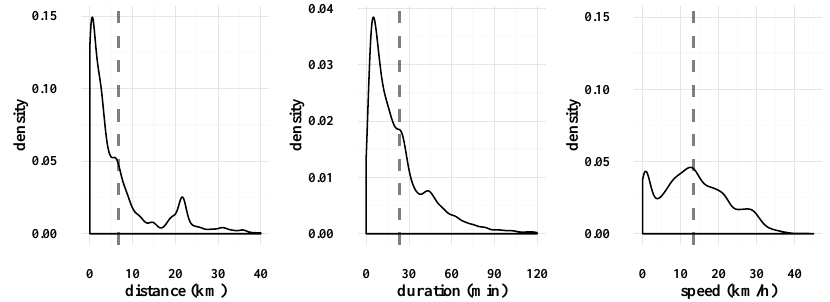
Figure 5. Density estimation of the trip features (mean values are plotted as dashed lines).